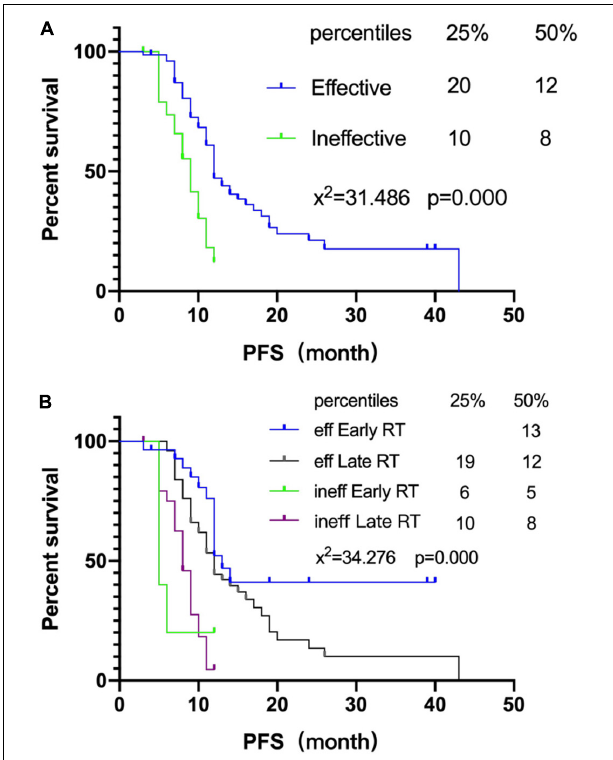
FIGURE 2 | Association of radiotherapy starting time with chemotherapy. (A) Survival curves of chemotherapy efficiency and PFS. (B) Survival curves of chemotherapy efficiency and PFS of different radiotherapy intervening groups.